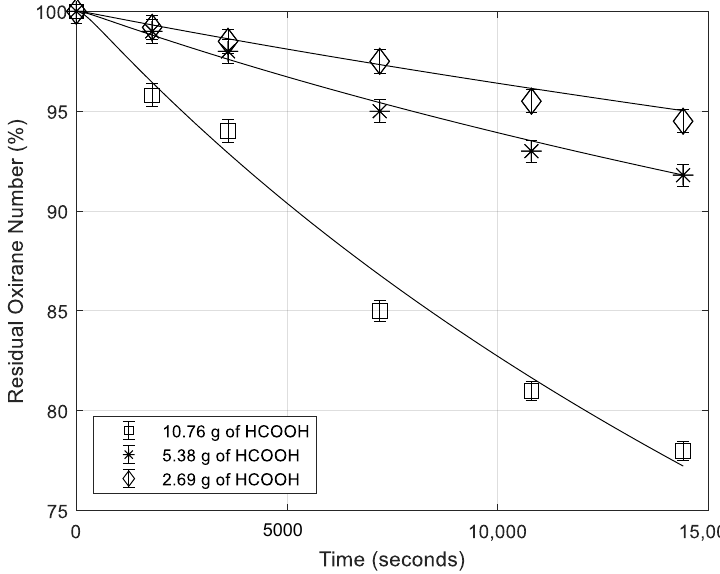
Figure 4. Residual oxirane number profiles obtained for different initial concentrations of formic acid. Points are experimental data lines that are calculated with the developed model (mass of catalyst 0.65 g; temperature 70 °C; rate of agitation 750 rpm).